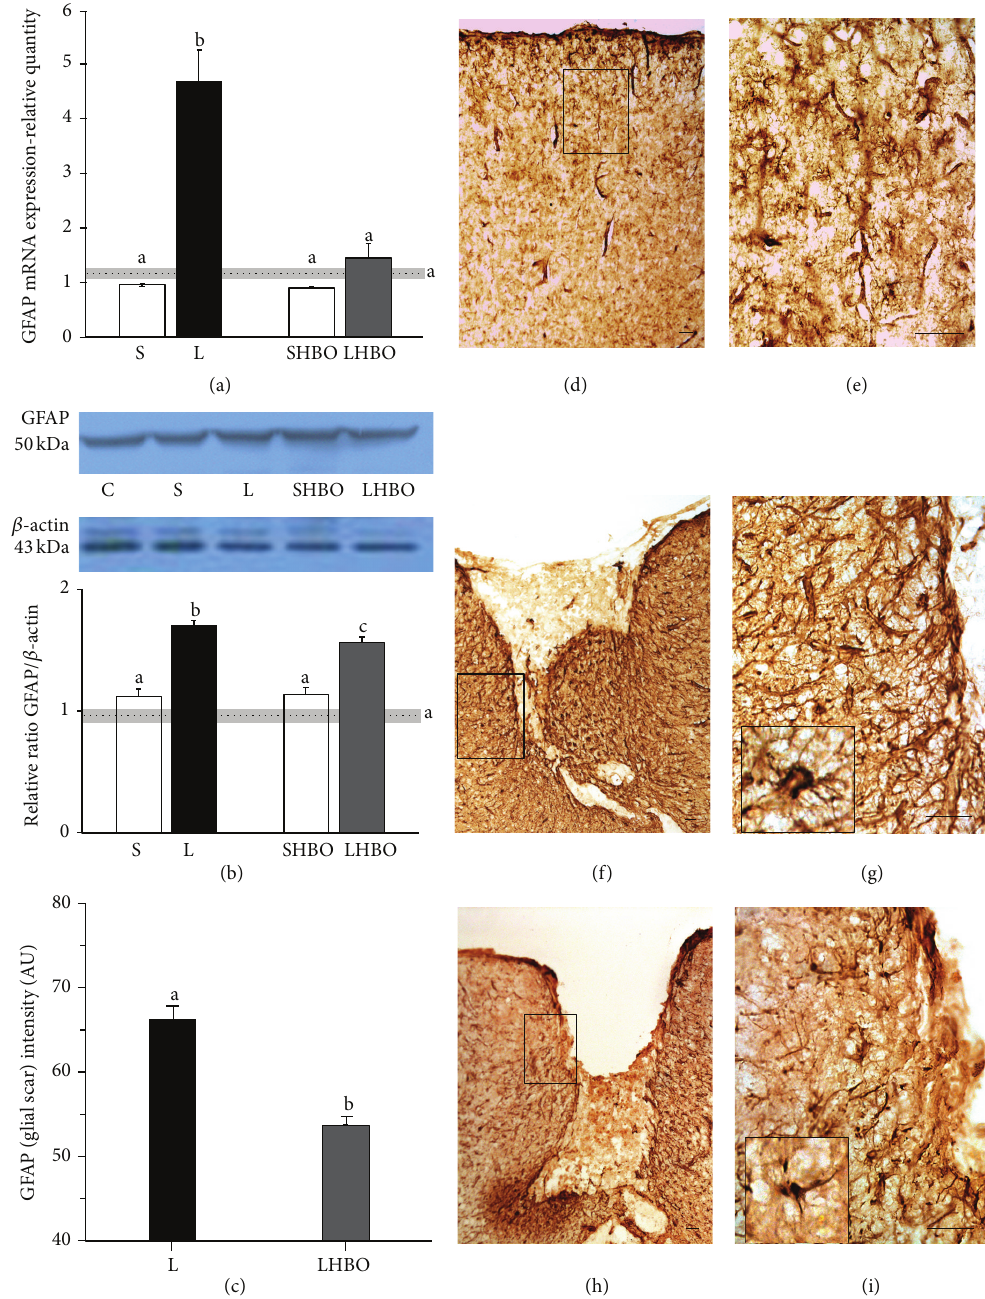
Figure 1: Effect of repetitive HBOT on GFAP expression after CSI. CSI provoked upregulation of GFAP expression both at mRNA (a) and protein (b) levels in the injured cortex compared to intact control and sham-operated animals, while repetitive HBOT reduced levels of GFAP mRNA to those detected in control groups. (a) Bars represent mean ± SEM of GFAP mRNA (relative to GAPDH). (b) Immunoblot analysis showed that GFAP was present as a single band with a molecular mass of about 50 kDa. Bars represent mean ± SEM of GFAP protein content (relative to 𝛽 -actin). Samples are from 4 animals per each group. Dot line represents mean of GFAP mRNA or protein level ± SEM (gray area) measured in control animals. Letters indicate significance levels ( 𝑃 < 0.005 ) between lesioned (L) and intact control group, L versus sham control (S) group, and L compared to lesioned group subjected to the HBO protocol (LHBO). The groups not sharing a common letter are statistically different. Level of significance was analyzed using Student’s 𝑡 -test. (c) The luminosity of glial scar is obtained by measuring GFAP staining intensity around the lesion site and presented on histogram. ((d) and (e)) Throughout the cortex of intact rats a small number of fibrous GFAP + astrocytes is seen. ((f) and (g)) At 10 days after injury a huge number of reactive astrocytes with pronounced hypertrophy of cell body and processes ((g) inset) form glial scar around the lesion site. ((h) and (i)) Ten successive HBOT significantly reduced glial scar formation, and the majority of astrocytes attained fibrous morphology ((i) inset). Rectangles indicate where the high magnification images are taken from. Scale bar = 50 𝜇